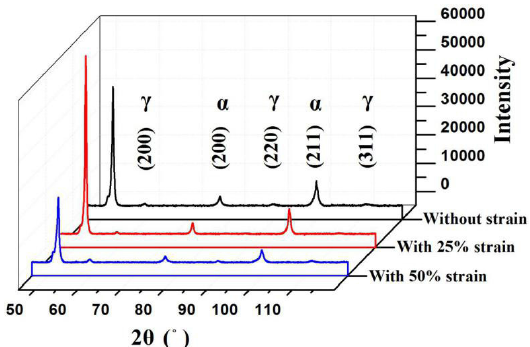
Figure 7. The diffraction peaks of specimens